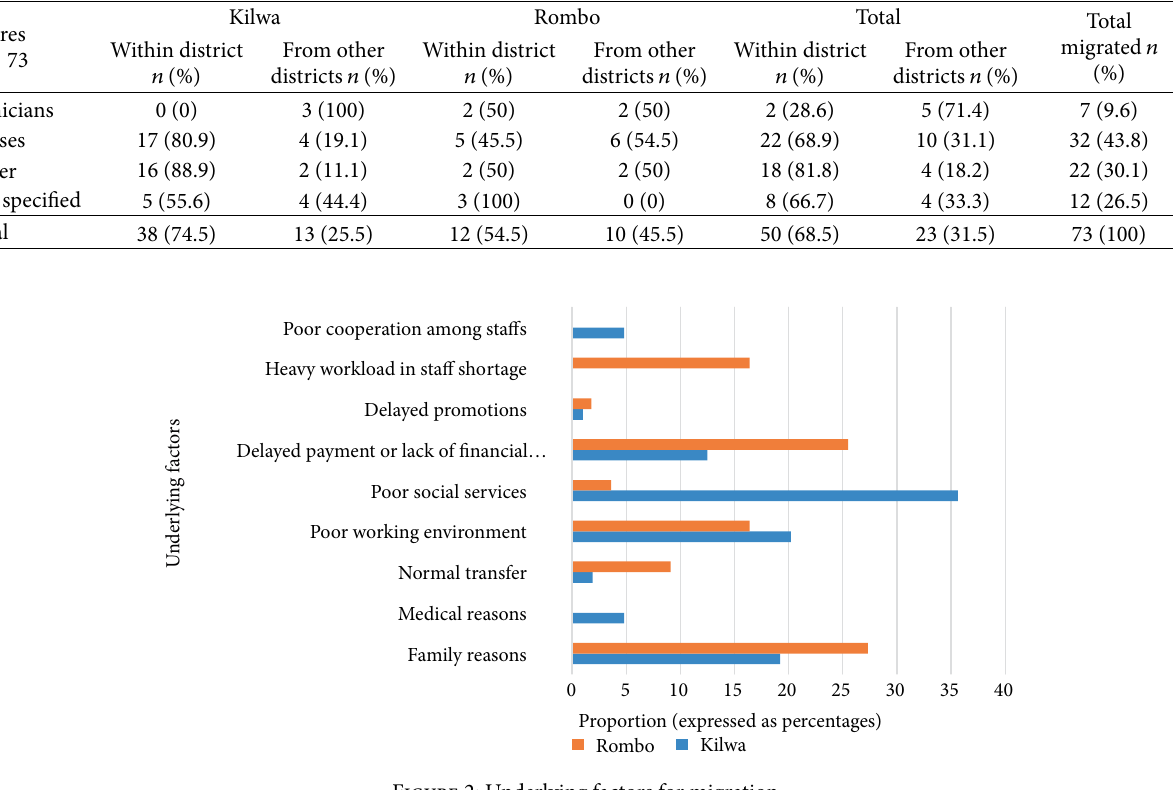
Figure 2: Underlying factors for